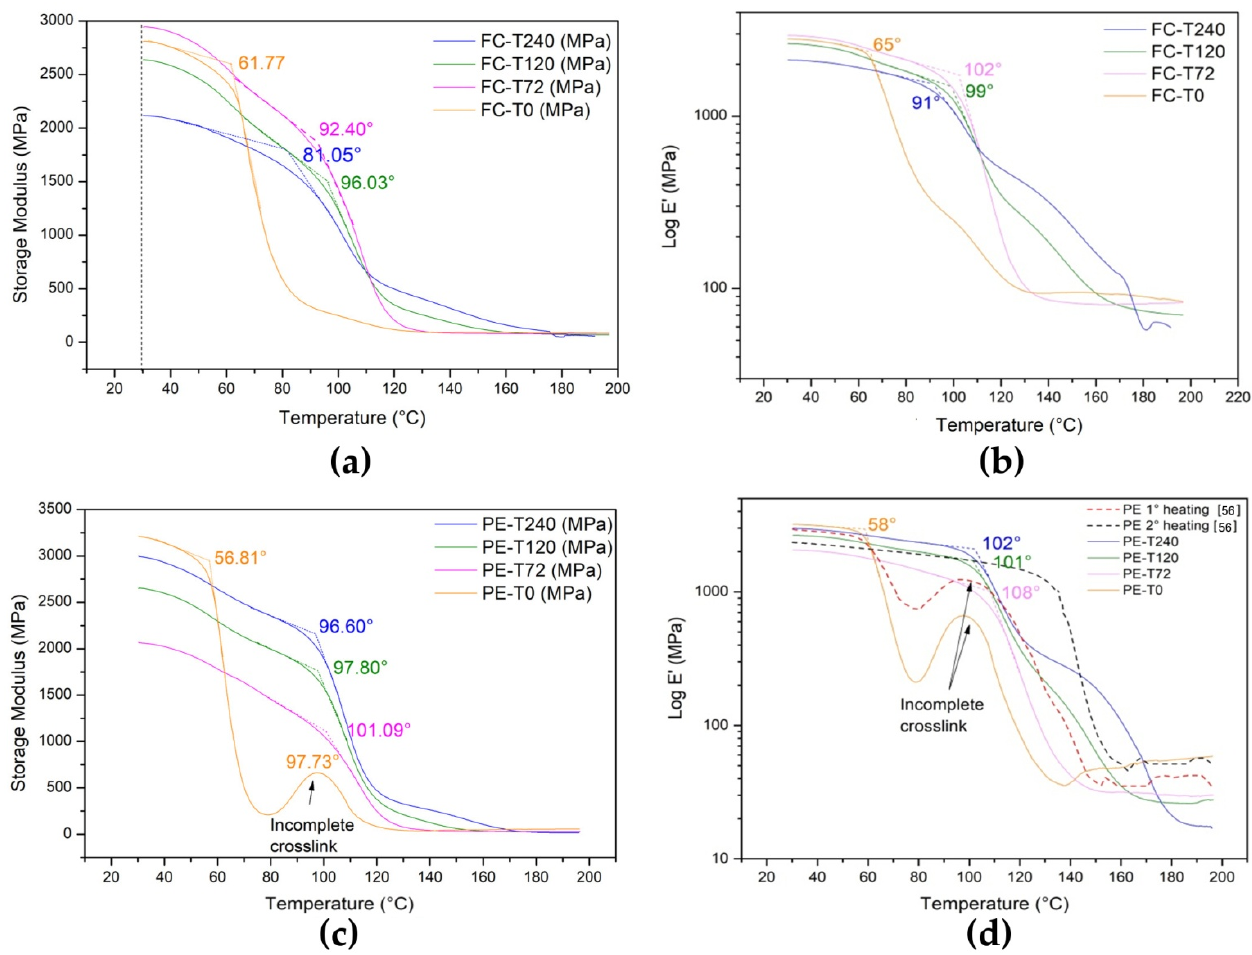
Figure 8. Storage modulus (E’) curves for samples unaged and thermally aged at different conditions: ( a ) fique fabric epoxy composites; ( b ) log E’ versus temperature for fique fabric epoxy composite; ( c ) plain epoxy; and ( d ) log E’ versus temperature for plain epoxy with additional first and second runs, dotted curves of the same DGEBA/TETA epoxy adopted from [55].